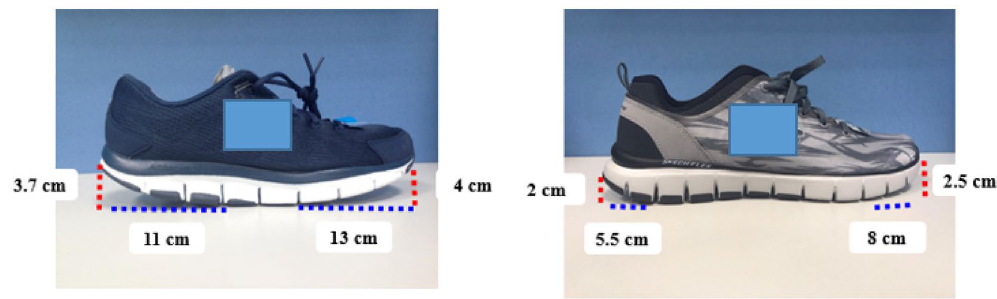
Figure 1. The dimensions of the two shoe types tested in this study. The left panel shows the rocker-soled shoe, and the right panel displays the normal